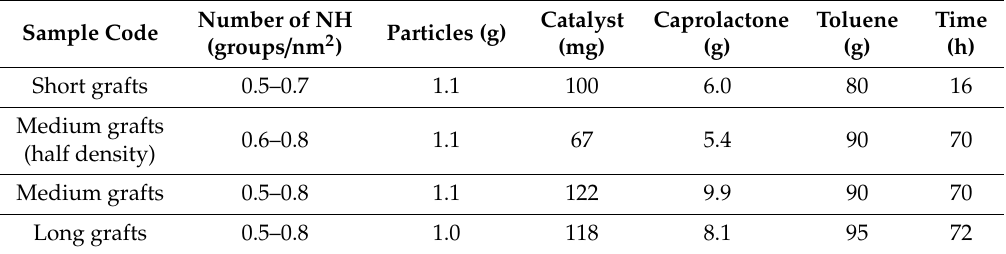
Table 1. Description of the di ff erent grafting